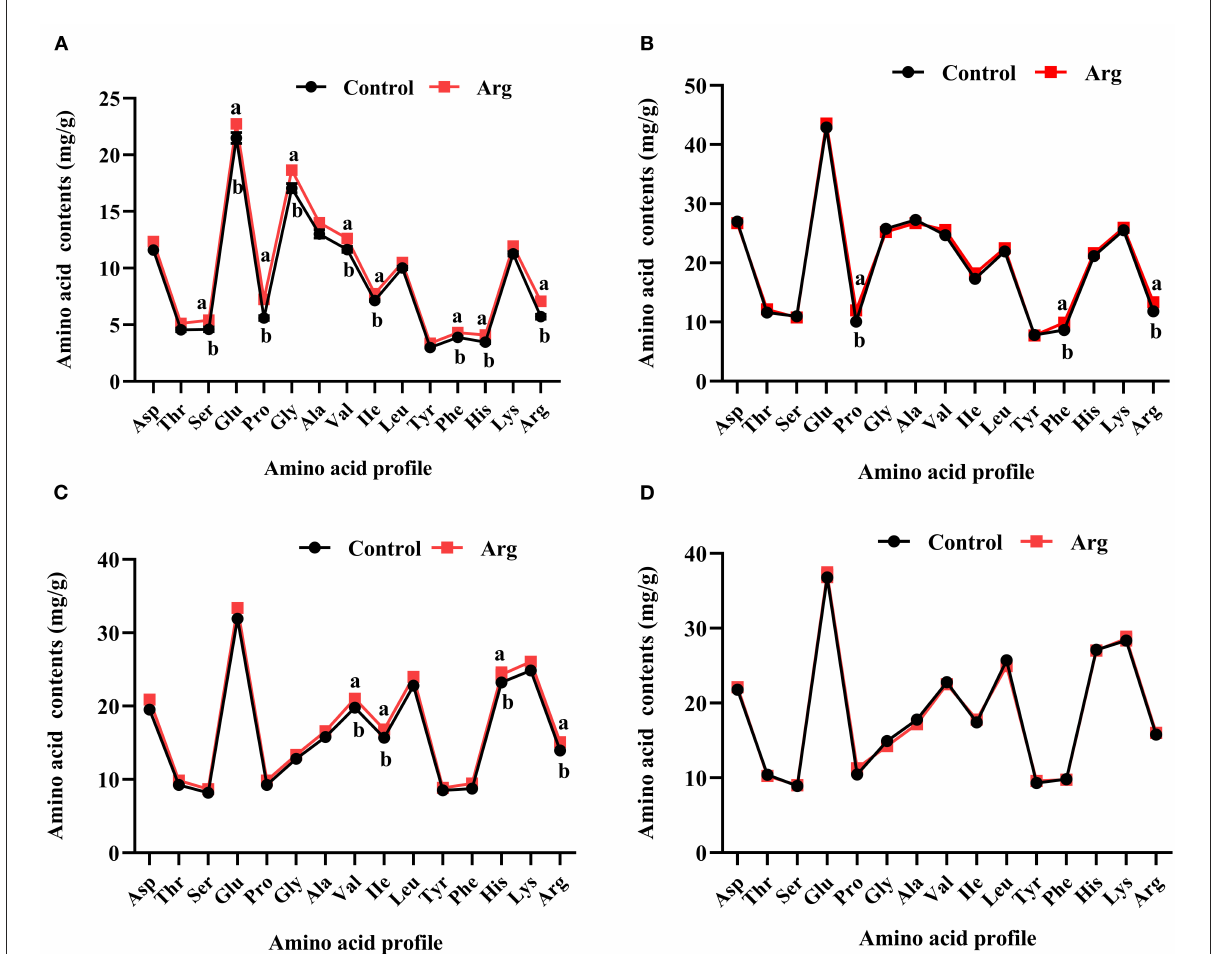
FIGURE1 Effects of in ovo feeding of L-arginine on the changes of amino acid profile in the breast muscle of slow-growing chickens. (A) Day of hatching; (B) day 21; (C) day 42; (D) day 63. Control, non-injected group; Arg, 1% L-arginine-injected group. Asp, aspartic acid; Thr, threonine; Ser, serine; Glu, glutamic acid; Pro, proline; Gly, glycine; Ala, alanine; Val, valine; Ile, isoleucine; Leu, leucine; Tyr, tyrosine; Phe, phenylalanine; His, histidine; Lys, lysine; Arg, arginine. SEM, standard error of the mean. Values are means with n = 8 per treatment. Different superscripts with the same time point indicate significant differences between the two groups ( P <